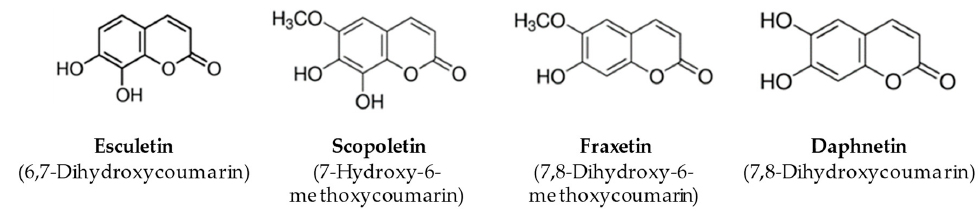
Figure 1. Chemical structure of coumarins.